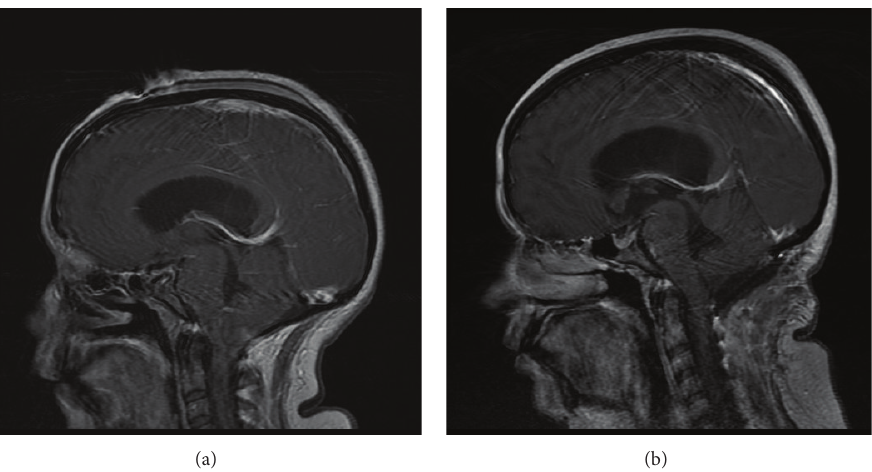
Figure 2: (a) Preoperative T 1 -weighted MRI with sagittal view. (b) Postoperative T 1 -weighted MRI with sagittal